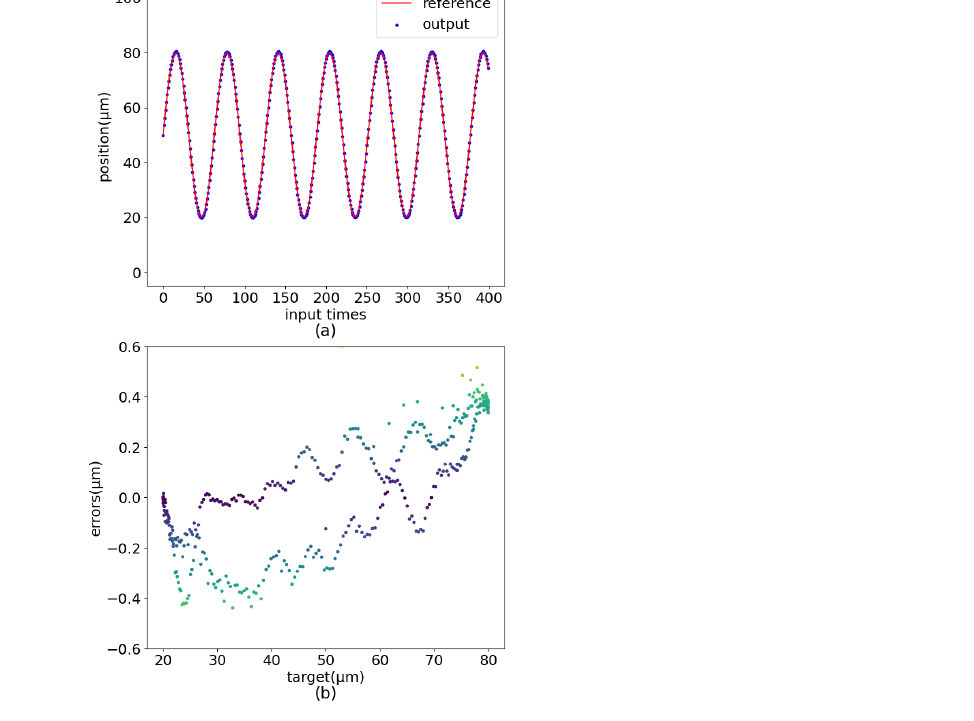
Figure 19. PEA-RNN without MLP control errors. ( a ) Curve comparision. ( b ) Error distribution.